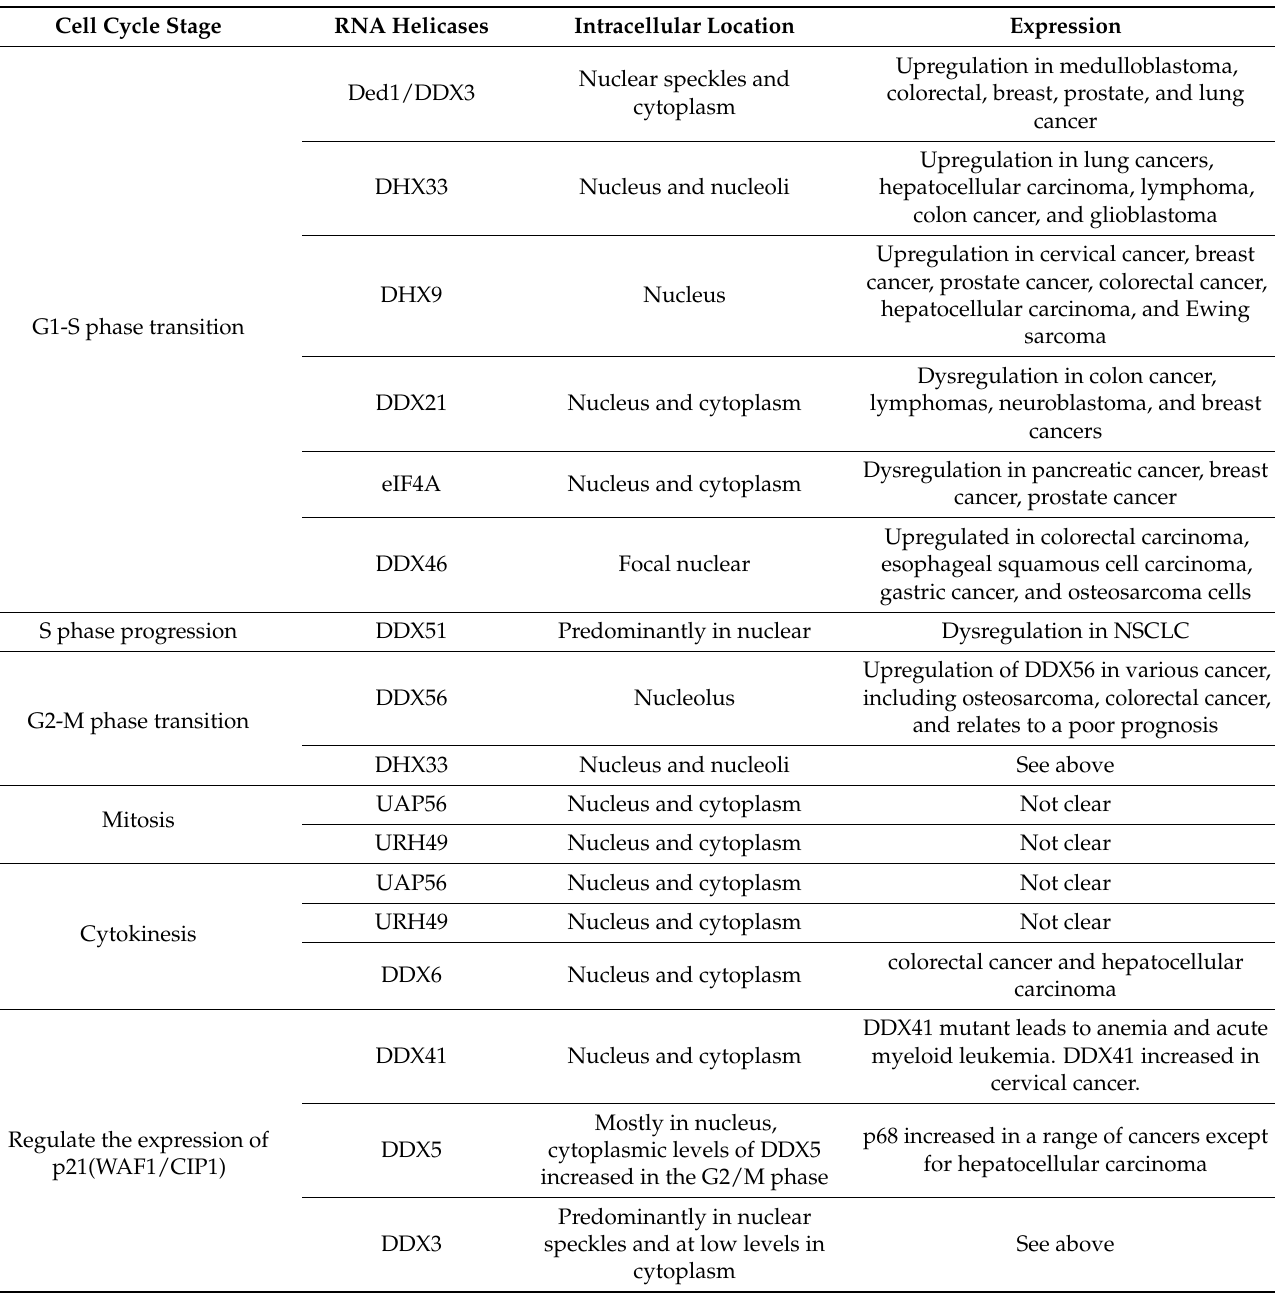
Table 1. RNA Helicases in each Cell Cycle Stage and their Intracellular